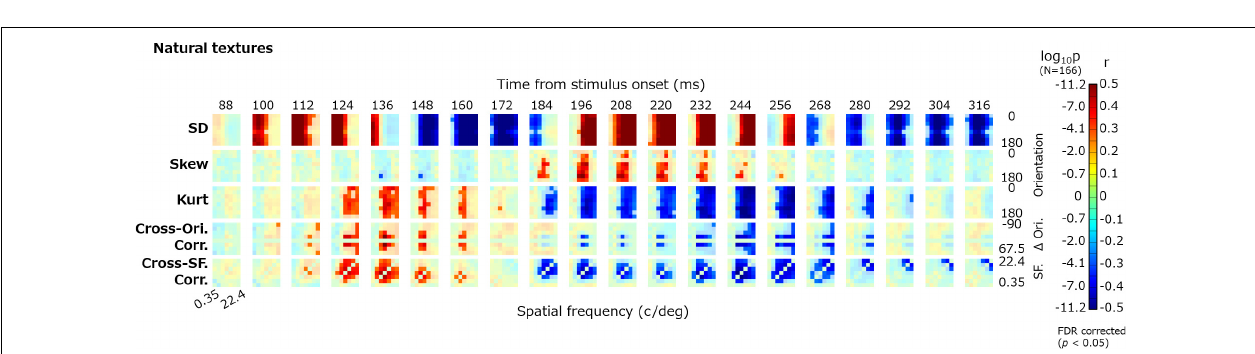
FIGURE 3 | Visual evoked potentials (VEPs) for texture images. (A) Topography of the grand average VEPs for the natural textures, PS-synthesized textures, and phase-randomized (PR) textures, in rows from top to bottom. (B) VEPs at the occipital electrodes (mean of O1 and O2). The light-blue traces show VEPs for individual images and the thick blue traces represent the averages across images.